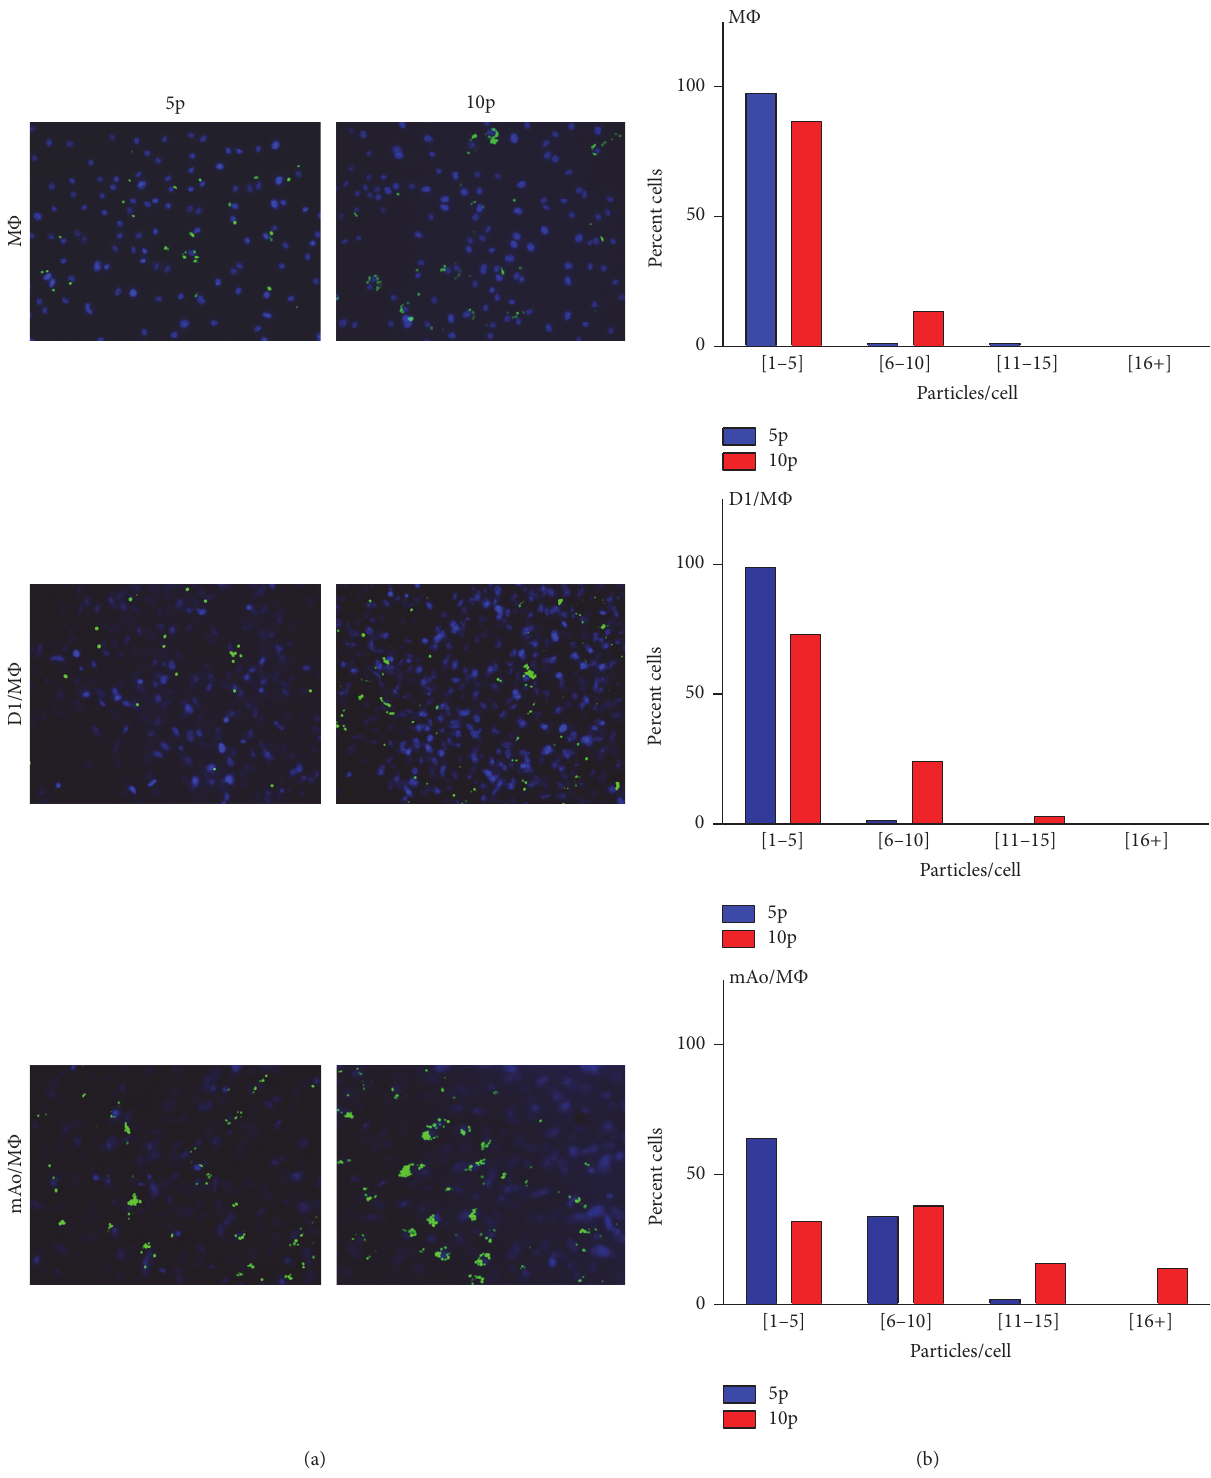
Figure 2: The phagocytic index of M Φ is increased when in coculture with aortic mesenchymal progenitor cells, mAo. Fluorescent micrographs of M Φ , mAo/M Φ , and D1/M Φ cultures exposed to 5 and 10 particles of FITC labeled zymosan-A per M Φ cell. Cultures were counterstained with DAPI to delineate nuclei (a). Micrographs were used to quantify M Φ uptake of zymosan particles. Counts per cell are presentedinthefollowingranges:[1–5],[6–10],[11–15],and[16+]zymosan-Aparticlespercell(b).Datarepresentfindingsfrom3experiments, each with an 𝑛 = 4